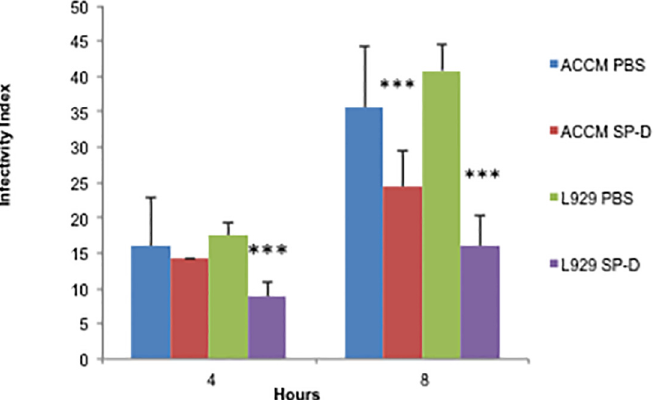
Fig 4. SP-D treatment results in a decrease in infectivity. ACCM-2 or L-929 passaged C . burnetii were stained with CSFE and treated overnight with SP-D or the equivalent volume of buffer alone (PBS). MH-S cells were infected at MOI 100 for 4 or 8 hours and fixed. MH-S nuclei were stained with Hoescht, the number of infected cells and bacteria was quantified via confocal microscopy, and the infectivity index was calculated (bound and internalized C . burnetii ). Data are displayed as mean ± standard deviation of infectivity from one representative of 5 experiments, n = 3. Student t-tests compare SP-D to PBS treated groups. * , p < 0.05, *** , p <